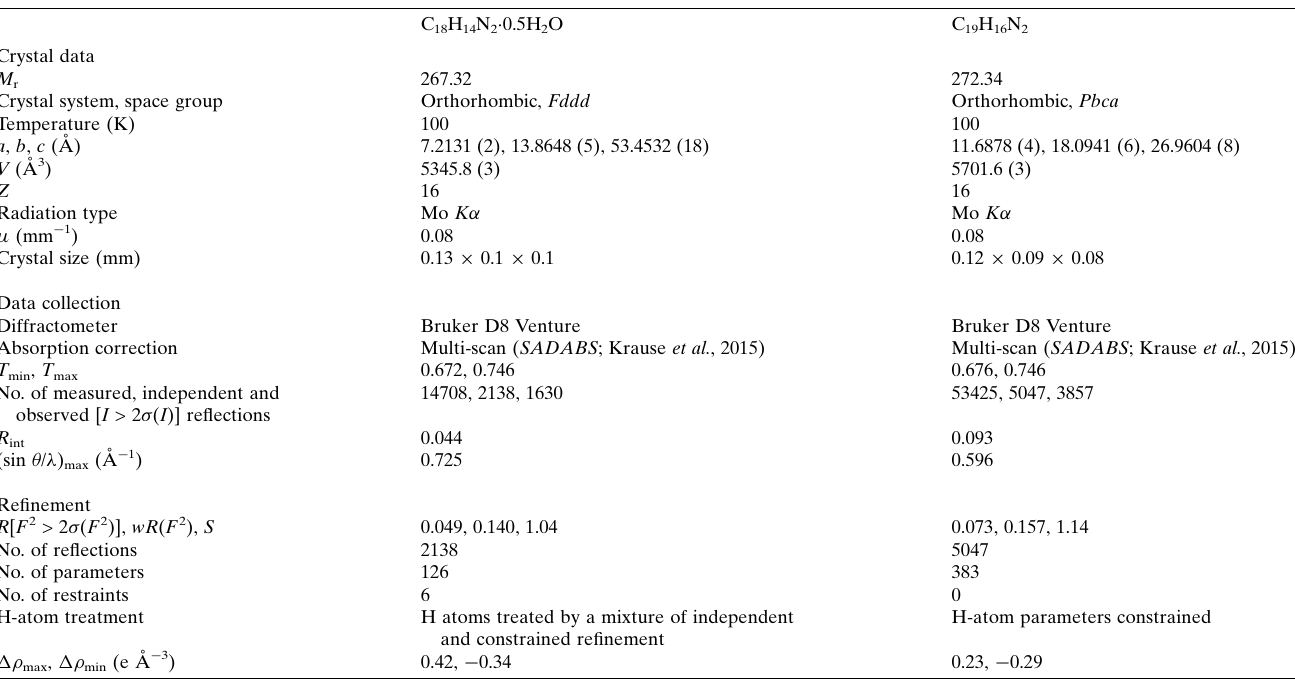
Table 2 Experimental